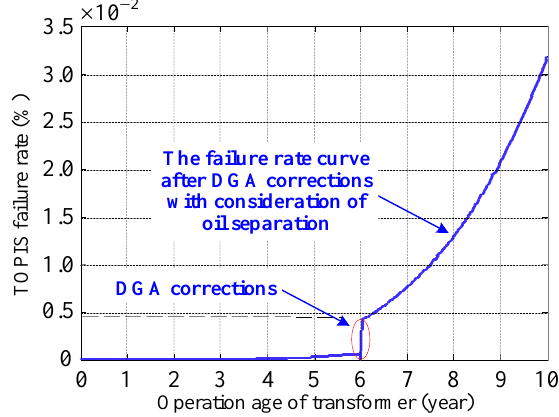
Figure 12. The curve of TOPIS failure rate in its sixth year operation period with considerations of the influences of oil separation.